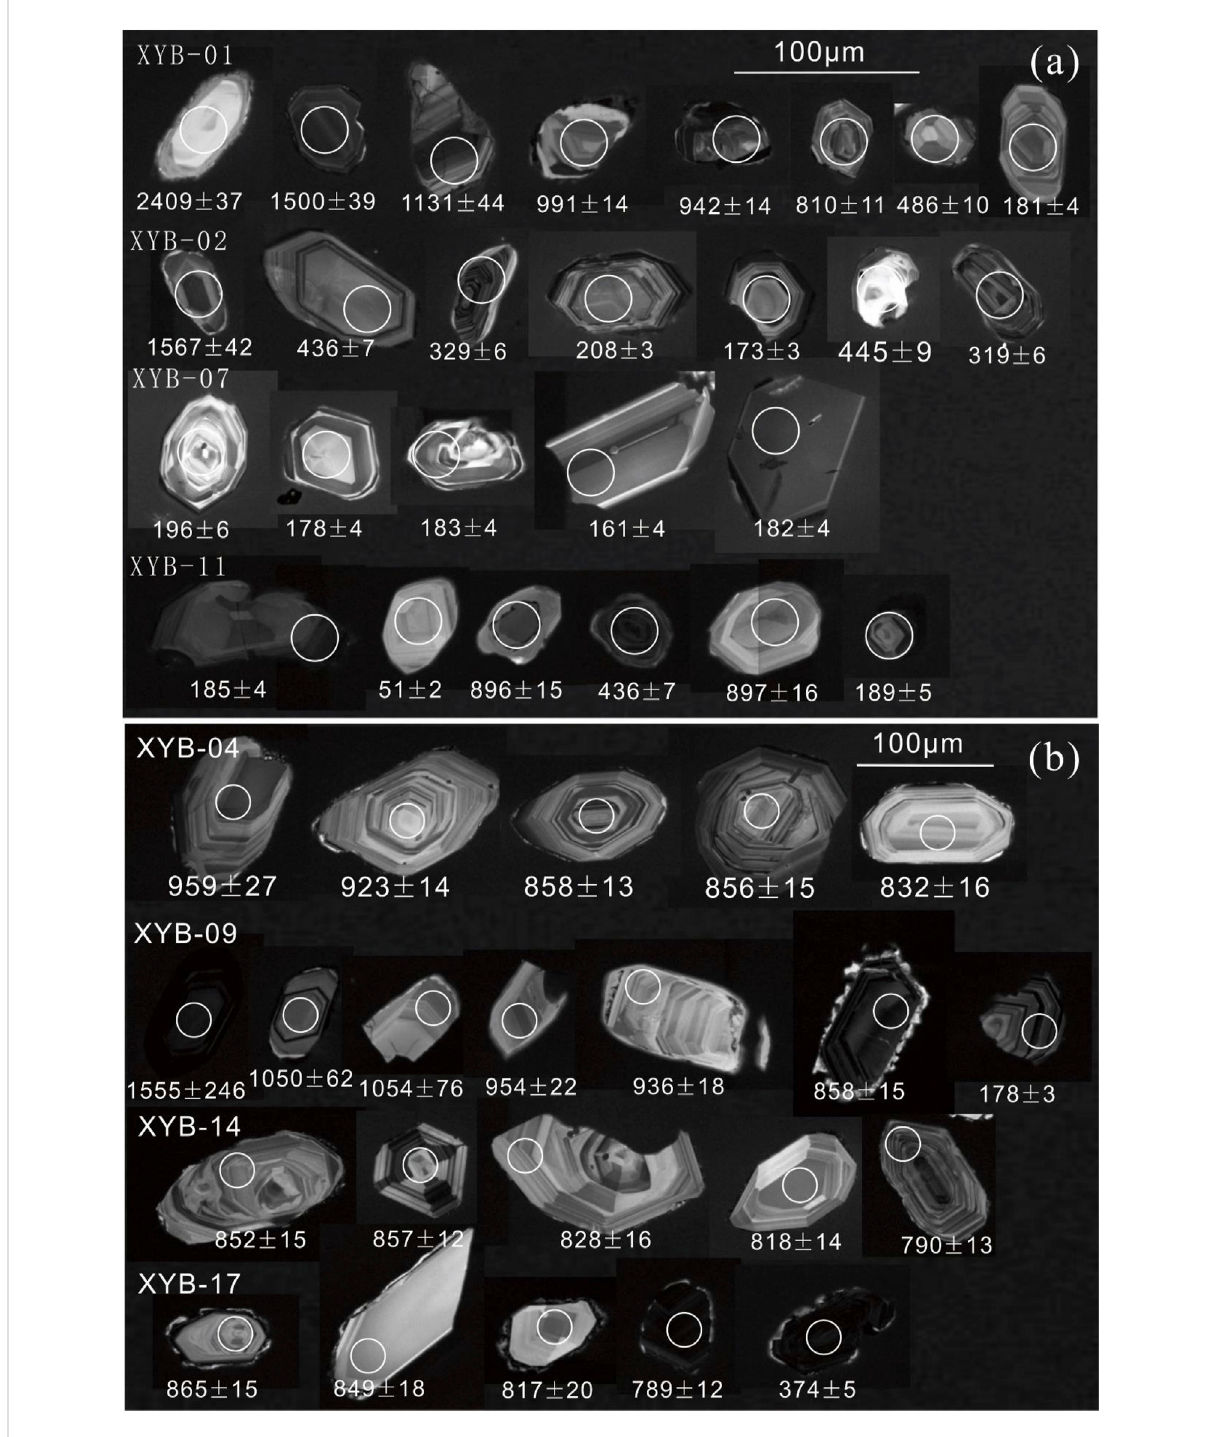
FIGURE 8 (A) Zircon cathodoluminescence image of amphibolite; (B) Zircon cathodoluminescence image of schist (age unit: